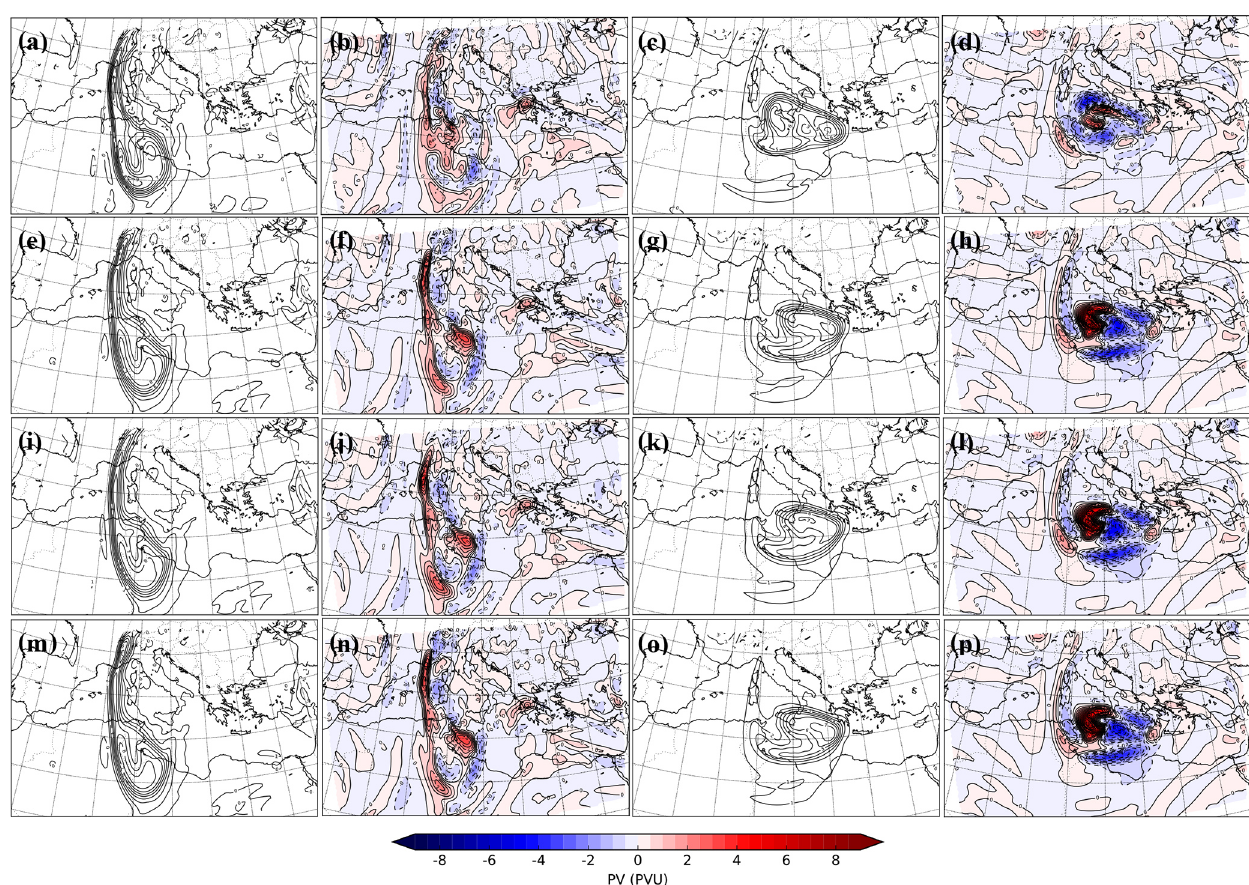
Figure 17. Comparison of PV at 300hPa between the numerical experiments and the ERA5 analysis at 00:00UTC (initial conditions) and 18:00UTC (maximum intensity registered at Malta). NODA, SYN, RSAMV and CNTRL experiments are shown in the first, second, third and fourth row, respectively. PV at 300hPa depicted by the different experiments at 00:00 and 18:00UTC is shown in the first and third column, respectively. The differences between ERA5 and the numerical experiments are shown in the second and fourth column,